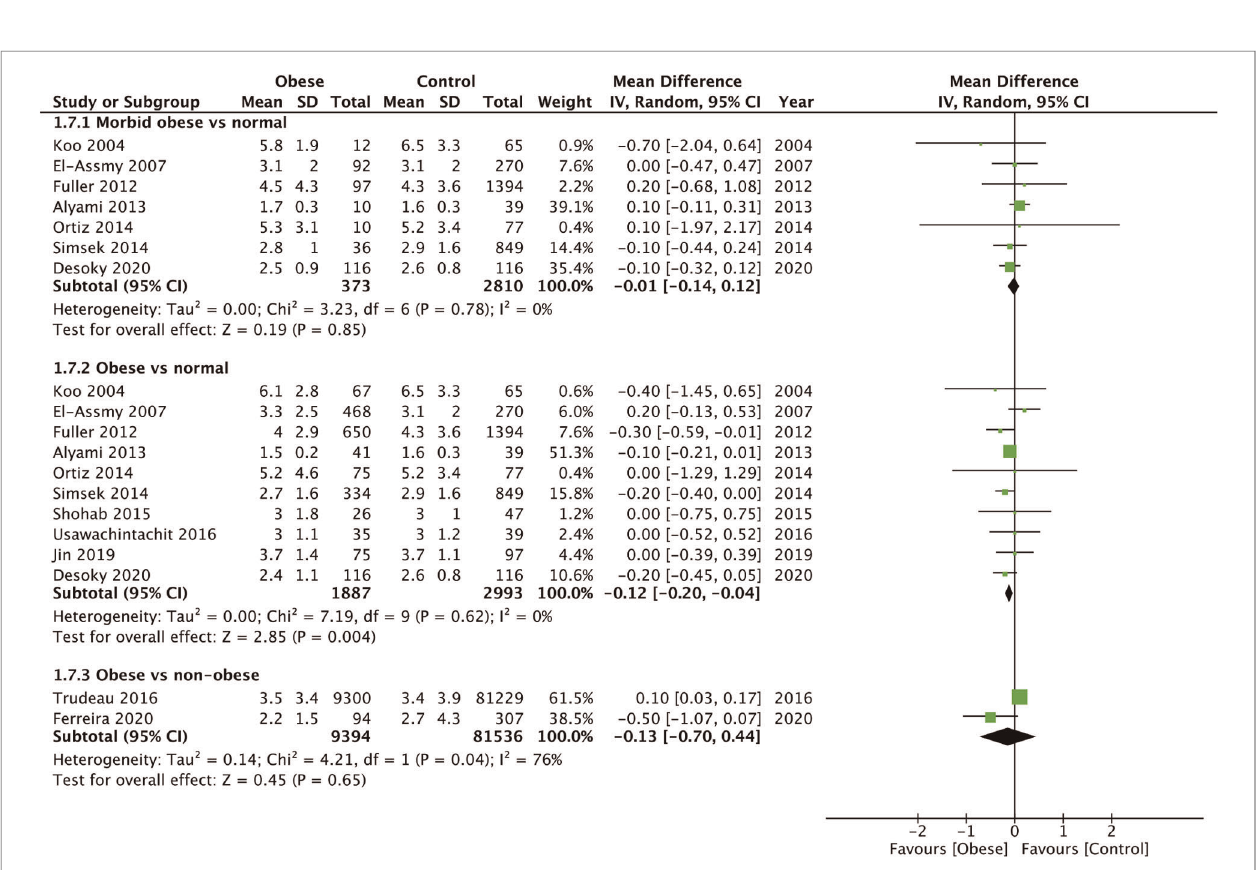
FIGURE 8 | Meta-analysis of LOS between morbid obese vs normal, Obese vs normal and obese vs non-obese patients.